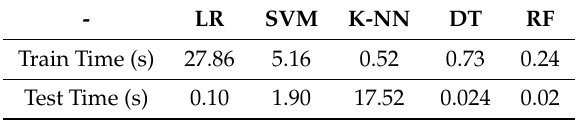
Table 19. Train and test time for different machine learning methods for activity